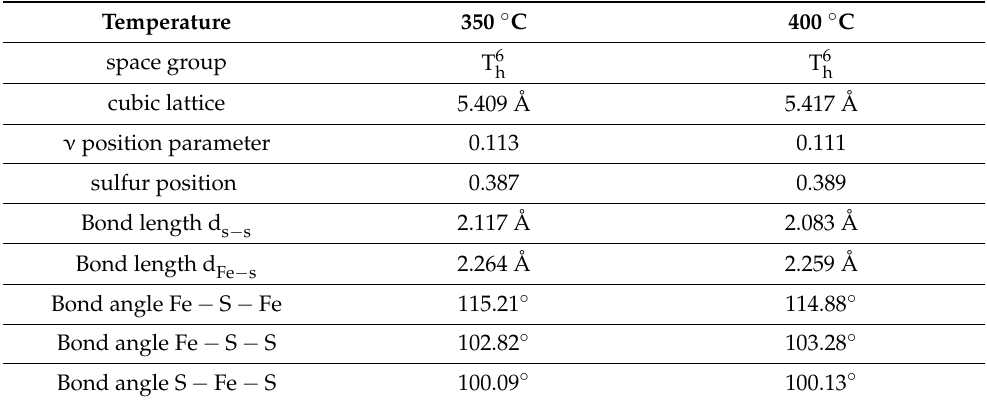
Table 5. Pyrite cell